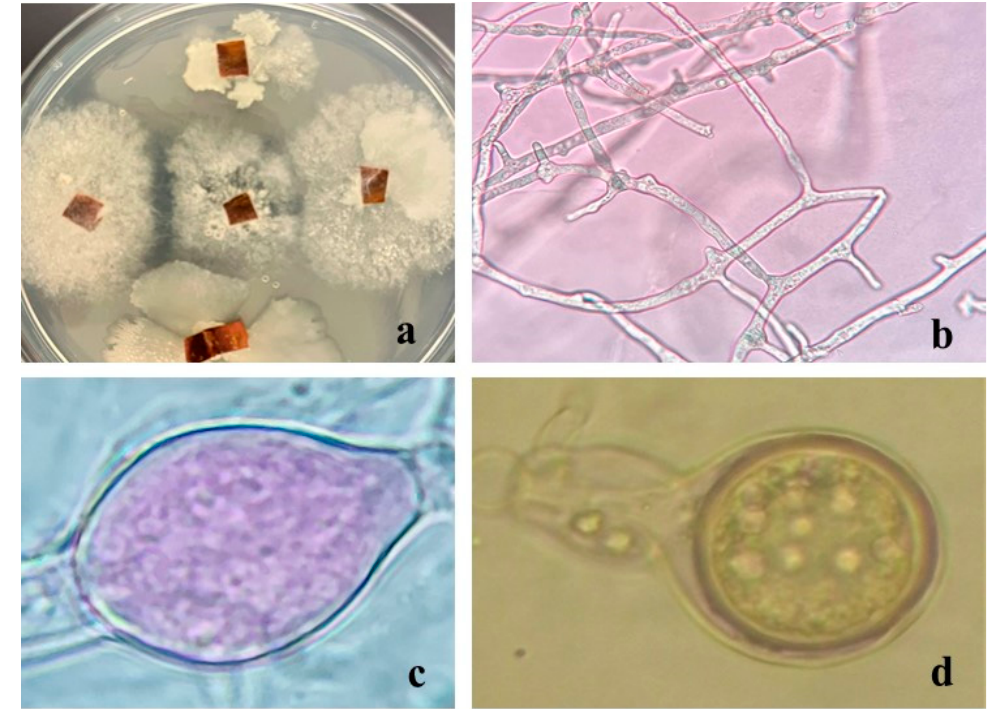
Figure 5. Re-isolation and characterization of the P. megasperma strain previously inoculated in ‘Garnem’ stem segments. ( a ) Mycelium in PDA plates subjected to microscopic observations; ( b ) microscopical aspect of somatic hyphae; ( c ) zoosporangia; ( d ) oospore.